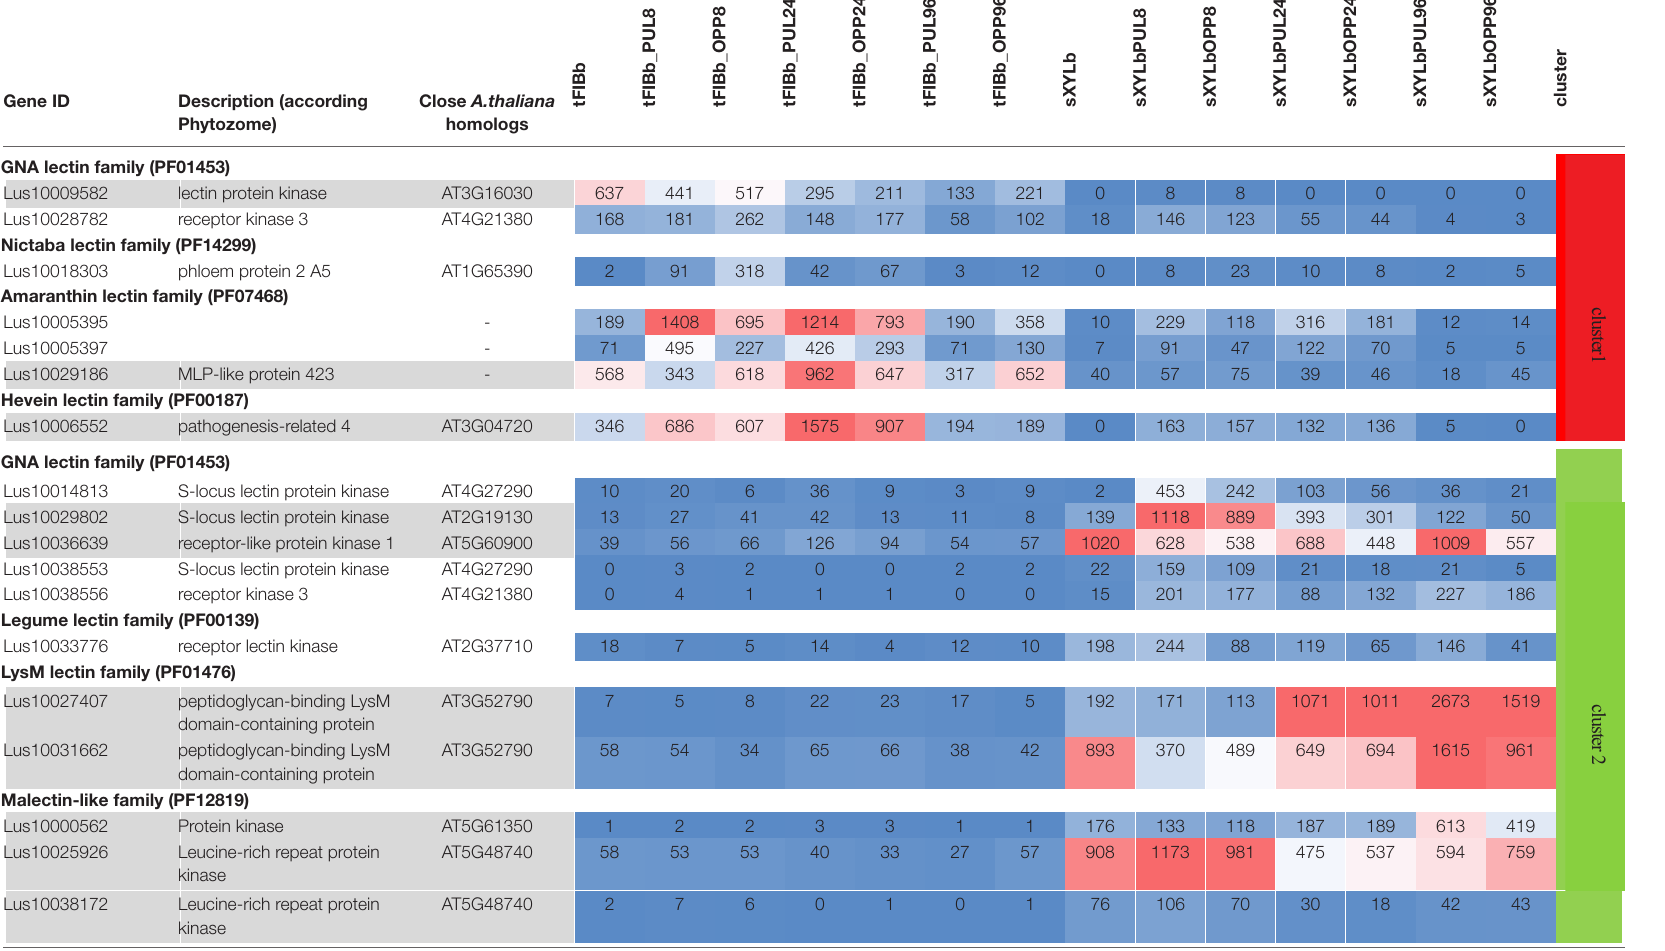
TABLE 6 | Changes in expression of Linum usitatissimum genes for proteins with lectin domains during graviresponse.